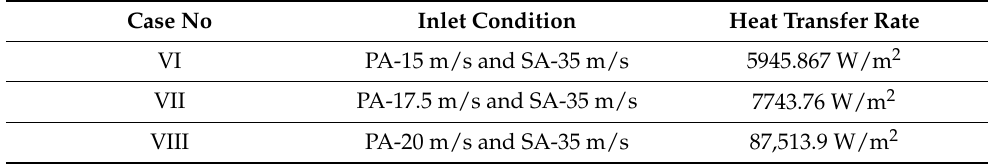
Table 9. Different cases Heat transfer rate.